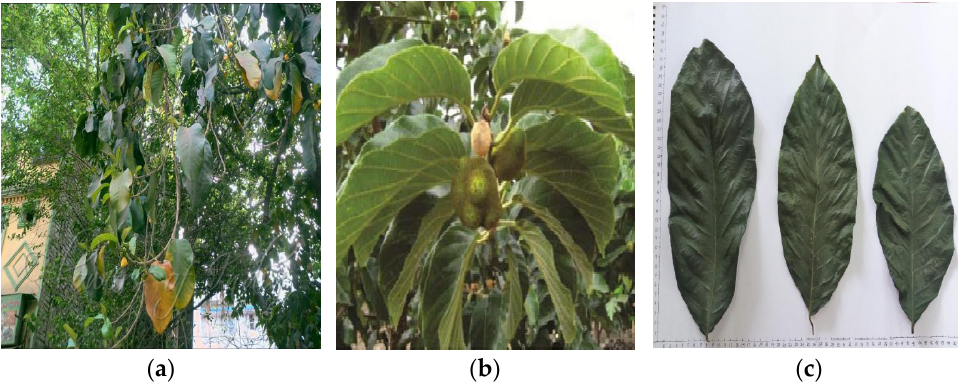
Figure 1. A. lacucha tree ( a ); A. lacucha fruit ( b ); A. lacucha leaves ( c